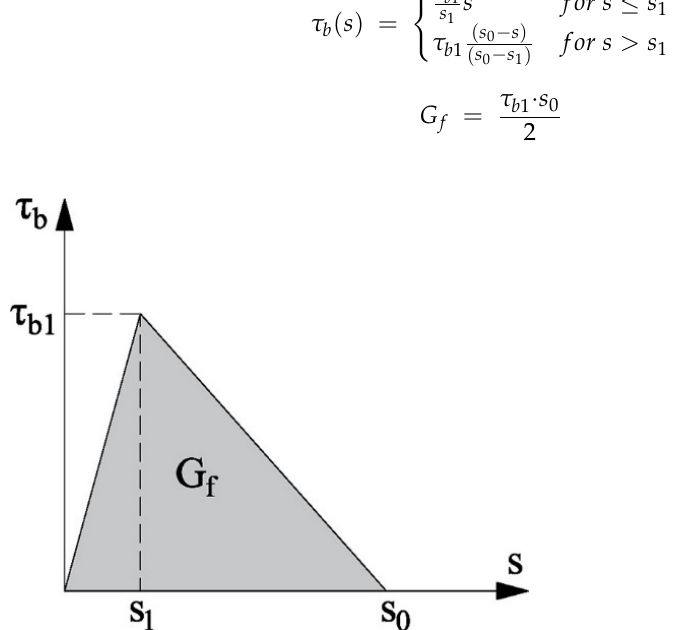
Figure 1. Bilinear local bond-slip law. This bilinear bond behaviour is usually described using direct shear tests